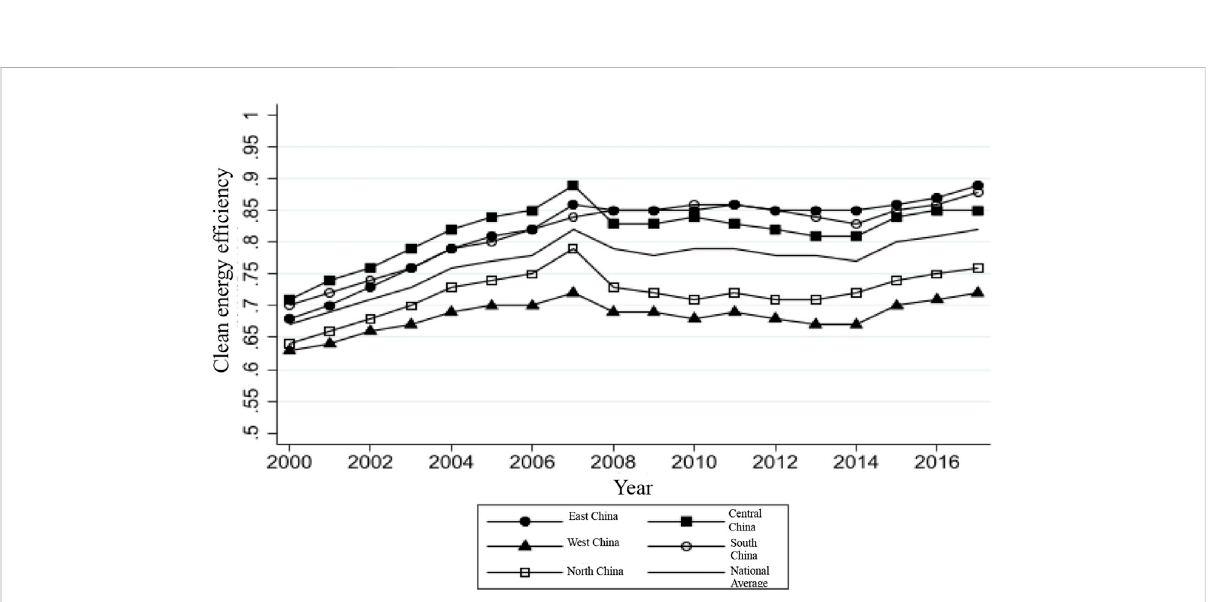
FIGURE 7 2000-2017 green and clean energy ef fi ciency structure of China (baseline grid emission